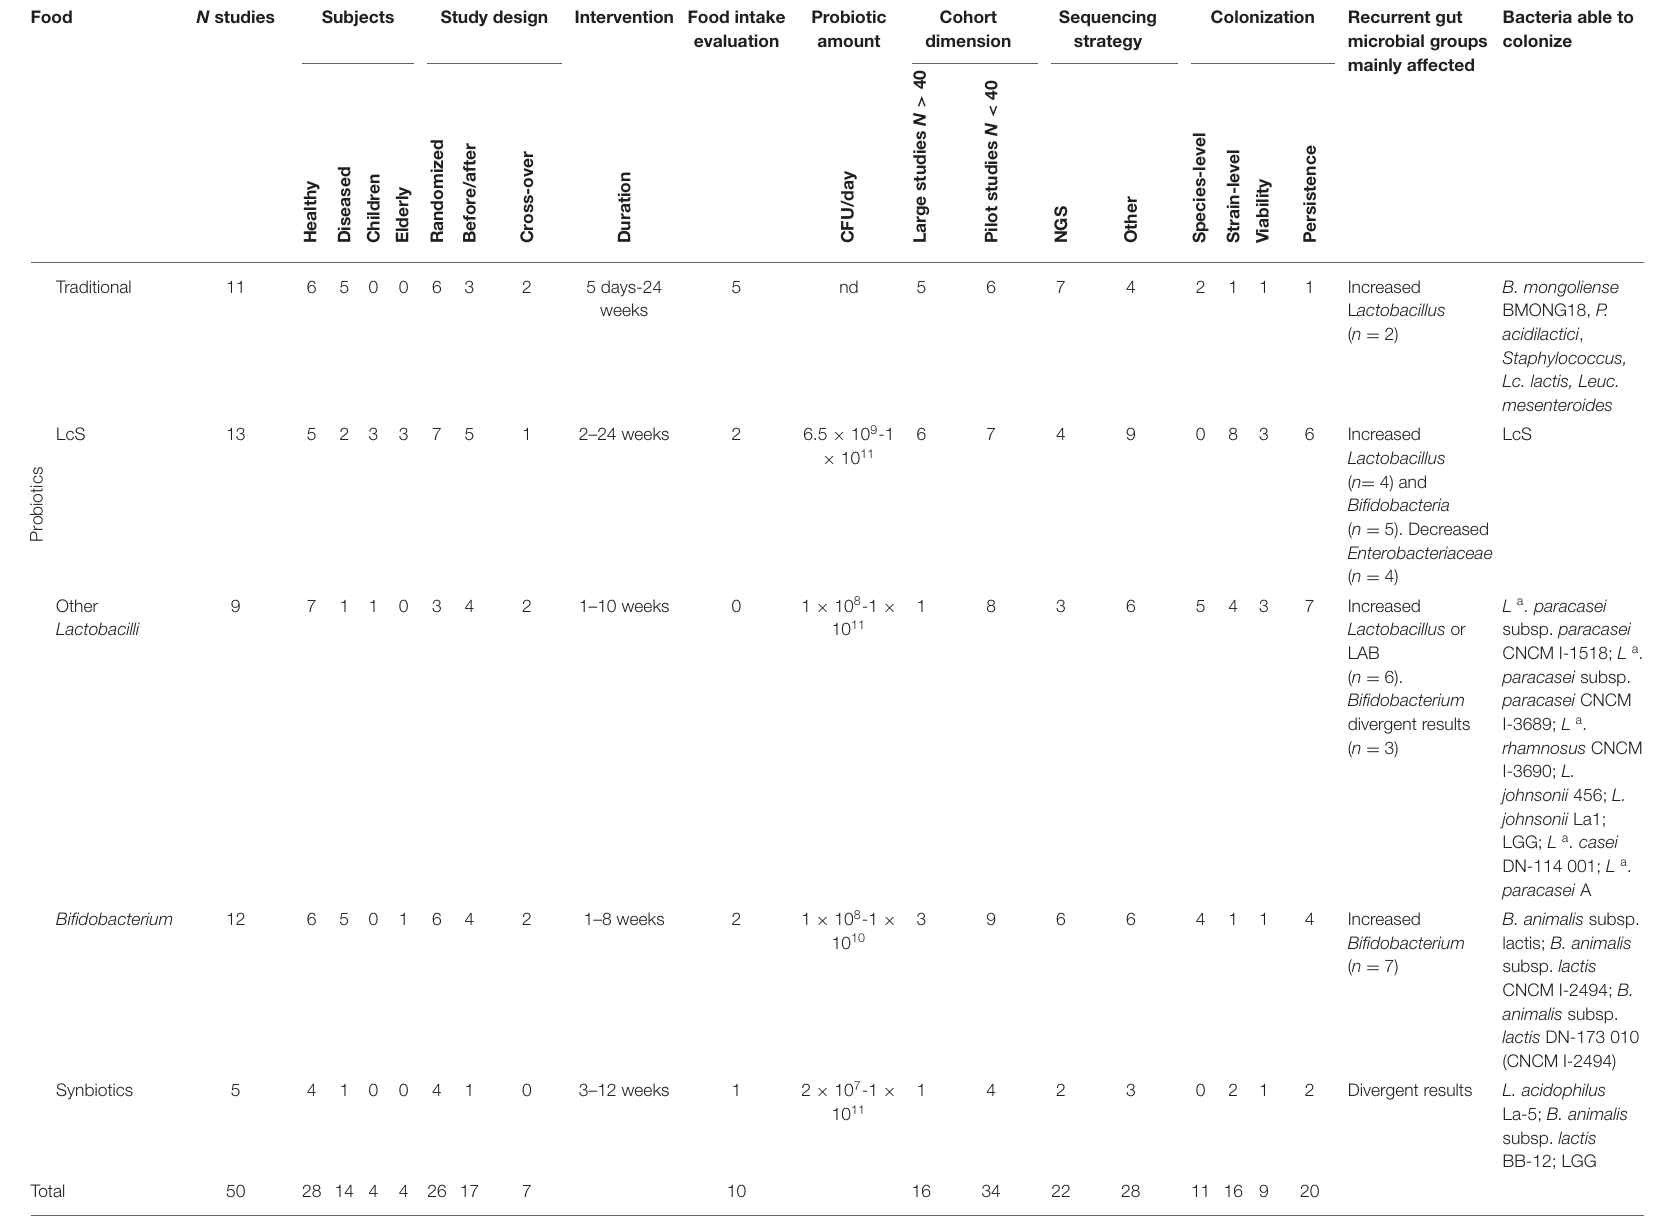
TABLE 7 | Summary of the comparative analysis of the intervention studies included in this